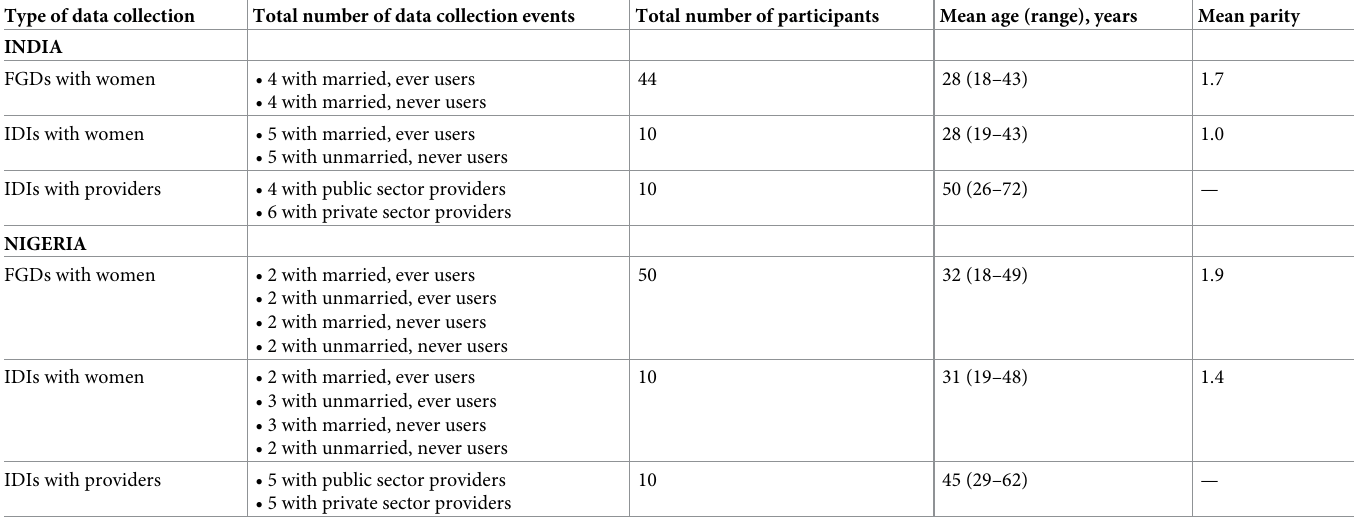
Table 2. Sample size and participant